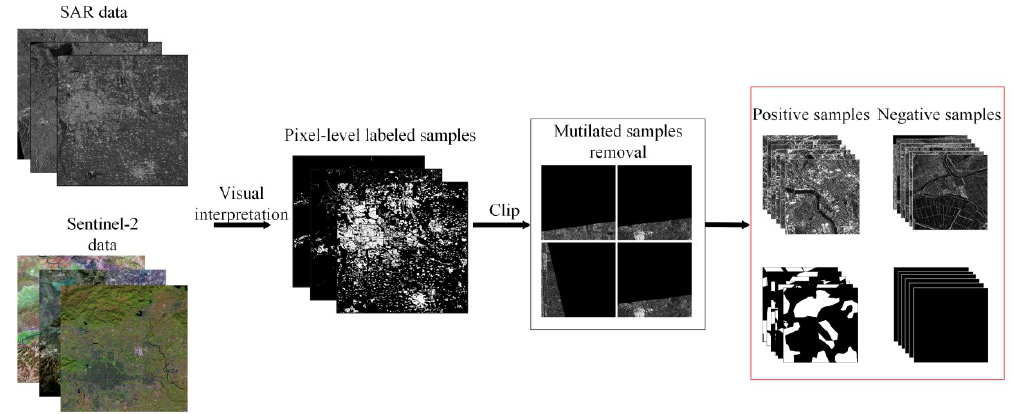
Figure 2. Production process of various samples.